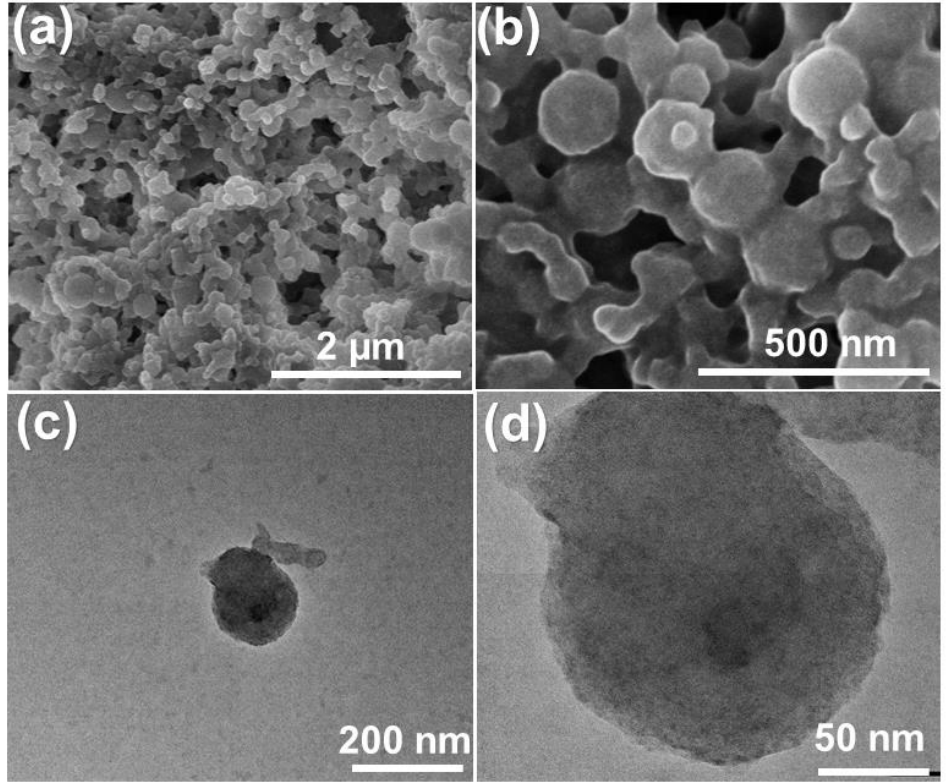
Figure 4. SEM ( a , b ) and TEM ( c , d ) images of the Se NPs prepared with the Se 4+ /CO volume ratio of 1/2.